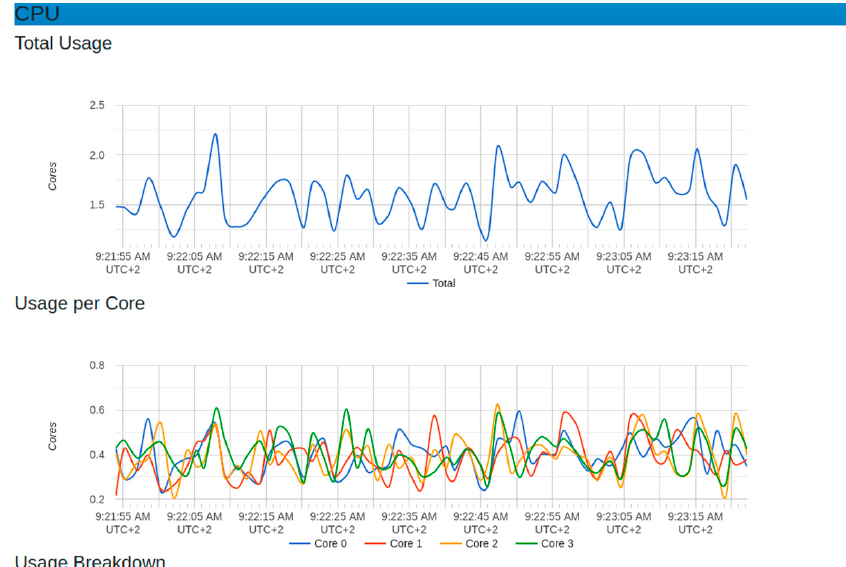
Figure 13. CPU resource behavior with normal sensor node setup.